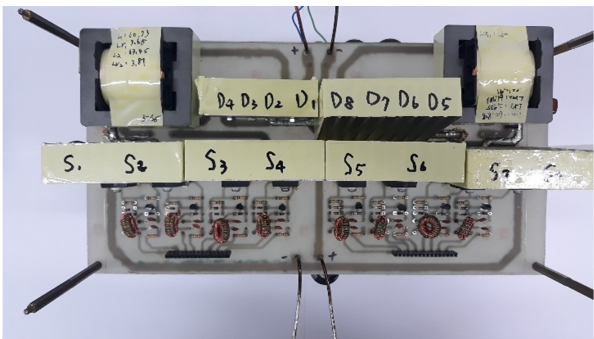
Figure 7. Picture of the laboratory prototype circuit.